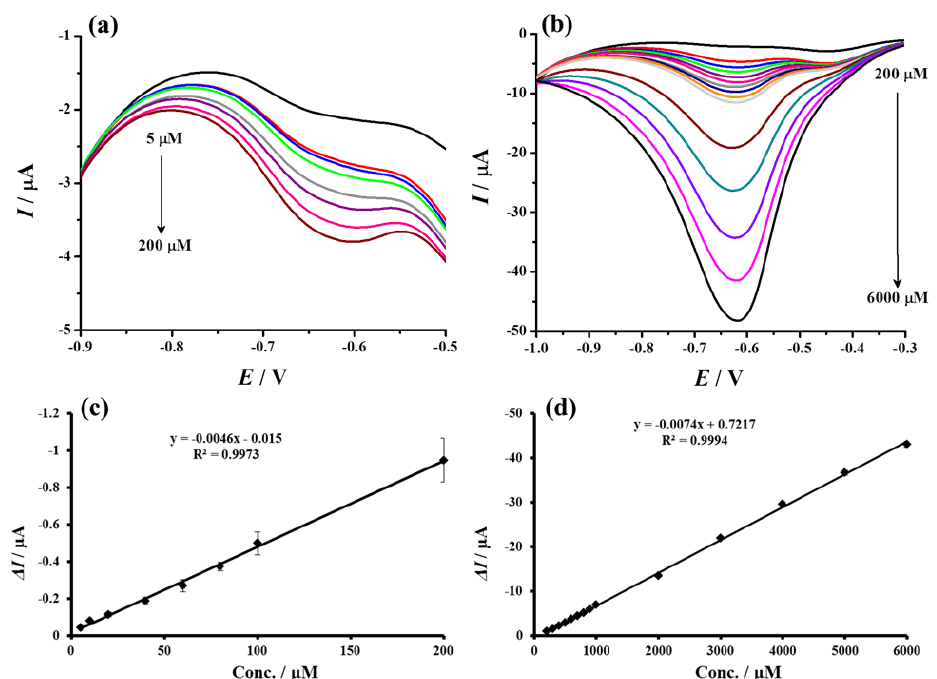
Figure 11. Differential pulse voltammograms recorded using proposed sensor (Au@TiO 2 /MWCNTs/GCE towards different concentrations of H 2 O 2 ( a ) 5 to 200 µM and ( b ) 200 to 6000 µM) in N 2 -saturated PBS (pH 7.4)). ( c , d ) Corresponding calibration curves from the current responses vs. H 2 O 2 concentrations plot. Table 2. Comparison of the proposed sensor with the recently reported H 2 O 2 sensors.